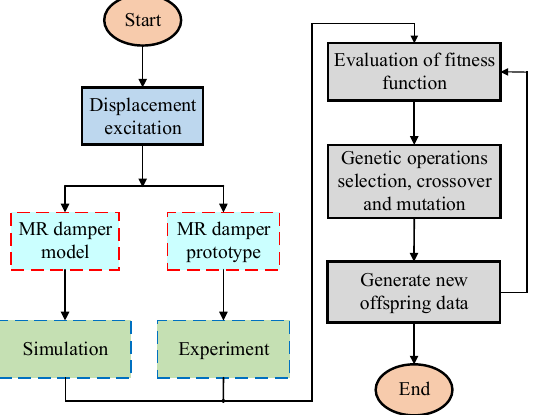
Figure 4. Parameter identification process of MR damper.